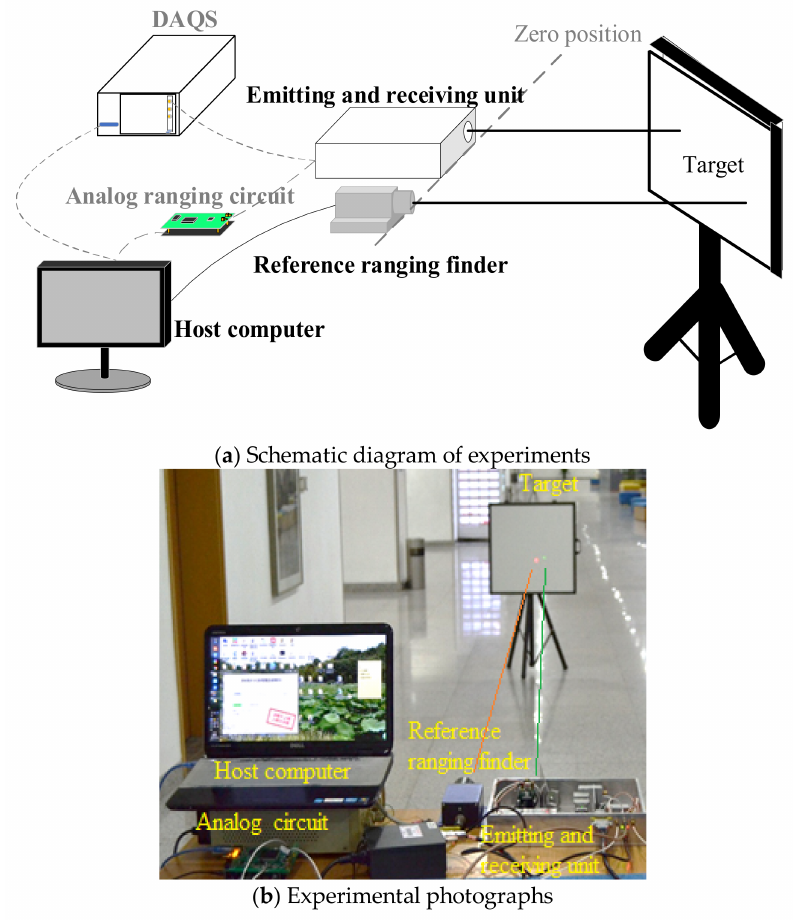
Figure 6. Experiments of two ranging systems and reference ranging